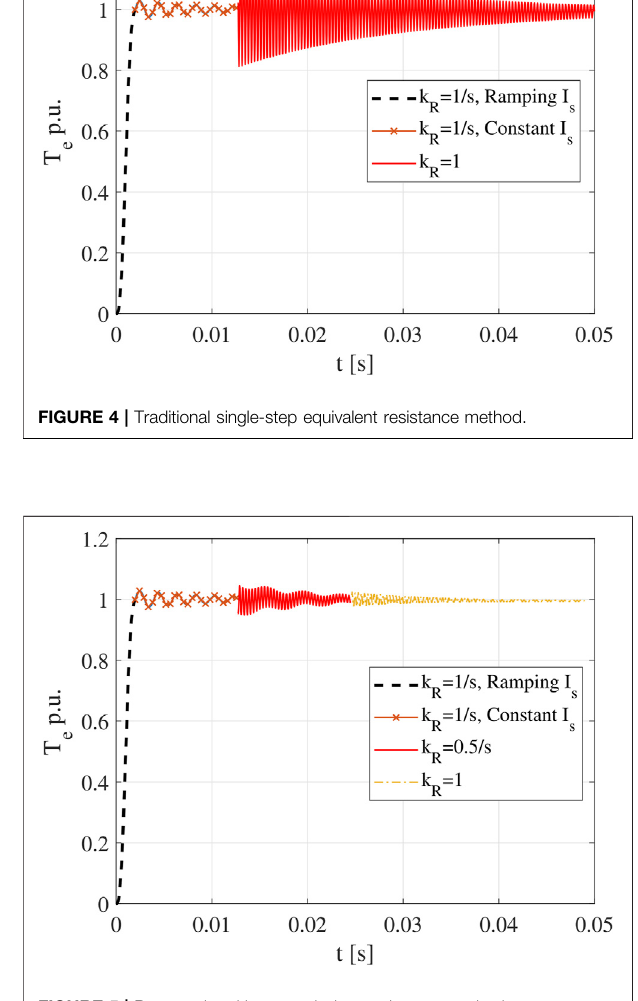
FIGURE 5 | Proposed multistep equivalent resistance